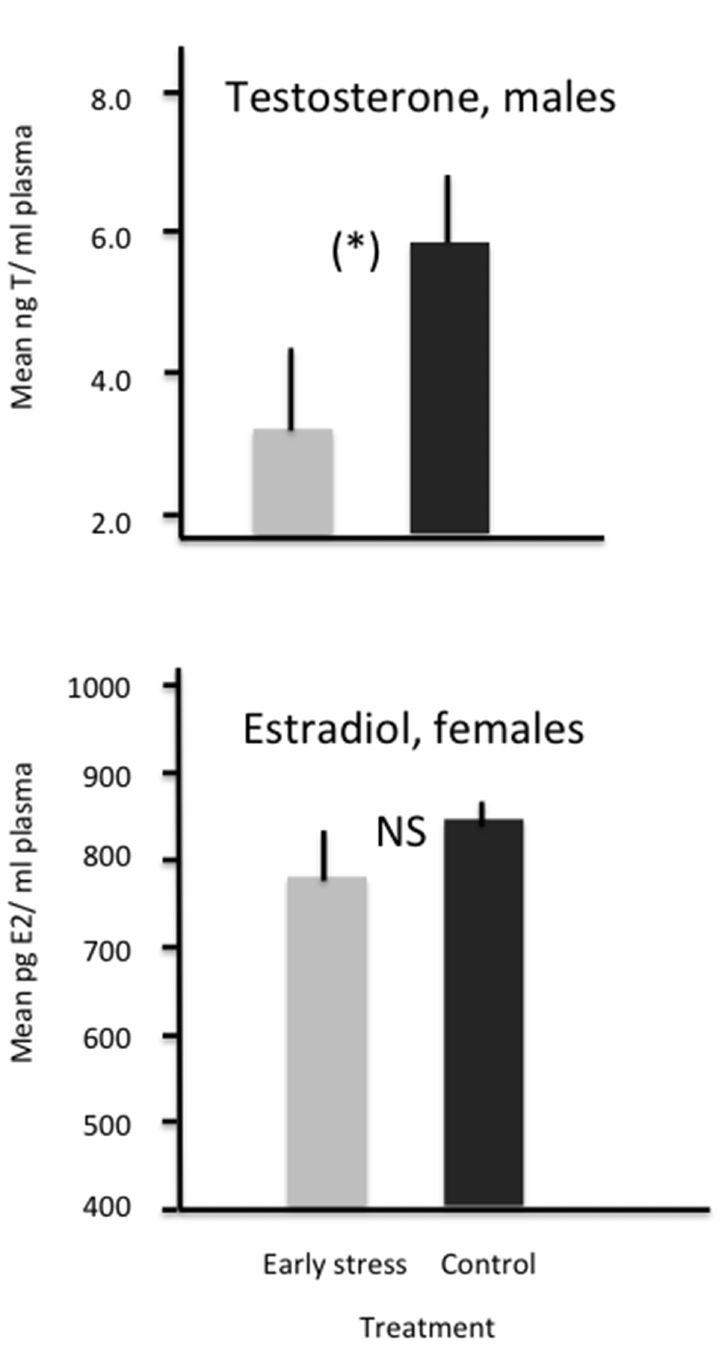
Fig 4. Mean (+/- SEM) plasma levels of testosterone in males (N = 16) and estradiol in females (N = 16) at 16 weeks of age. ( * ): P = 0.06, NS = not